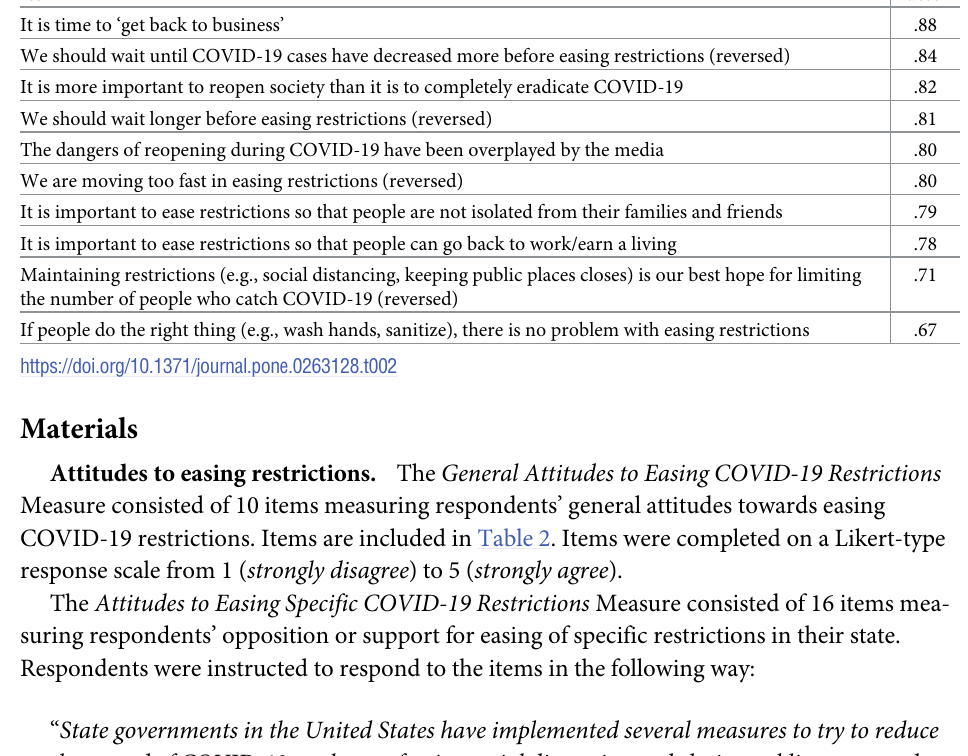
Table 2. Item loadings for a forced single-factor model for general attitudes to easing COVID-19 restrictions items using Principal Axis Factoring.